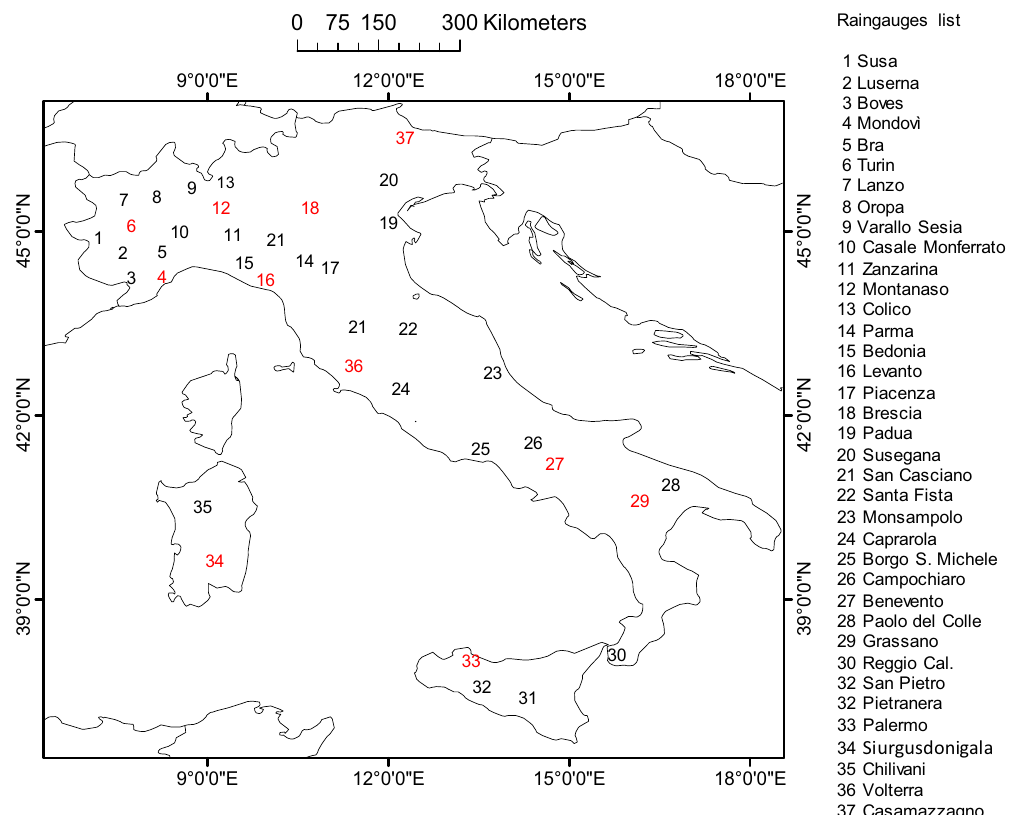
Figure 5. Spatial distribution of digital rain gauges used for calibration (black numbers) and validation (red numbers) across the Mediterranean Central Area.